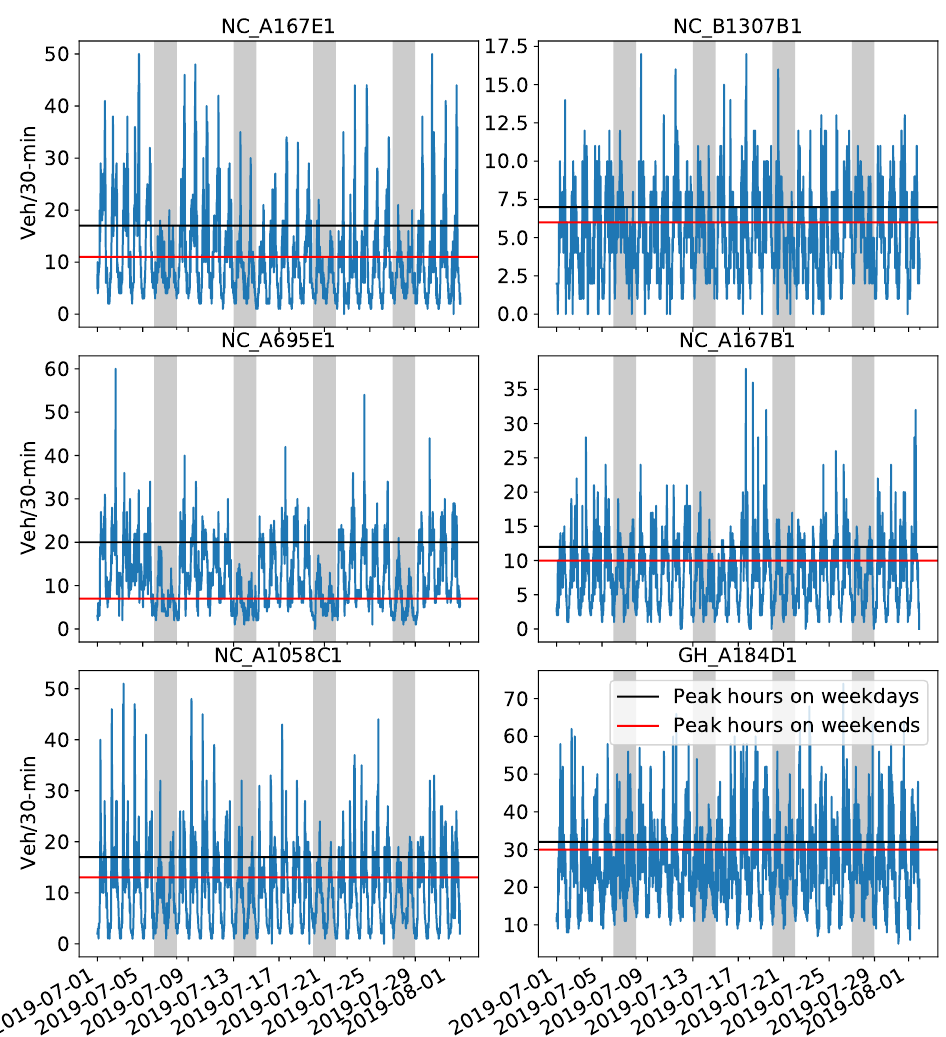
Figure 3. Aggregated vehicle counts showing the traffic volume during July 2019 (including 1 August 2019) at the six CCTV locations. Black and red lines represent the highest 25% of traf- fic volume on weekdays and weekends, respectively. Gray zones indicate weekends. Note the different scales of the